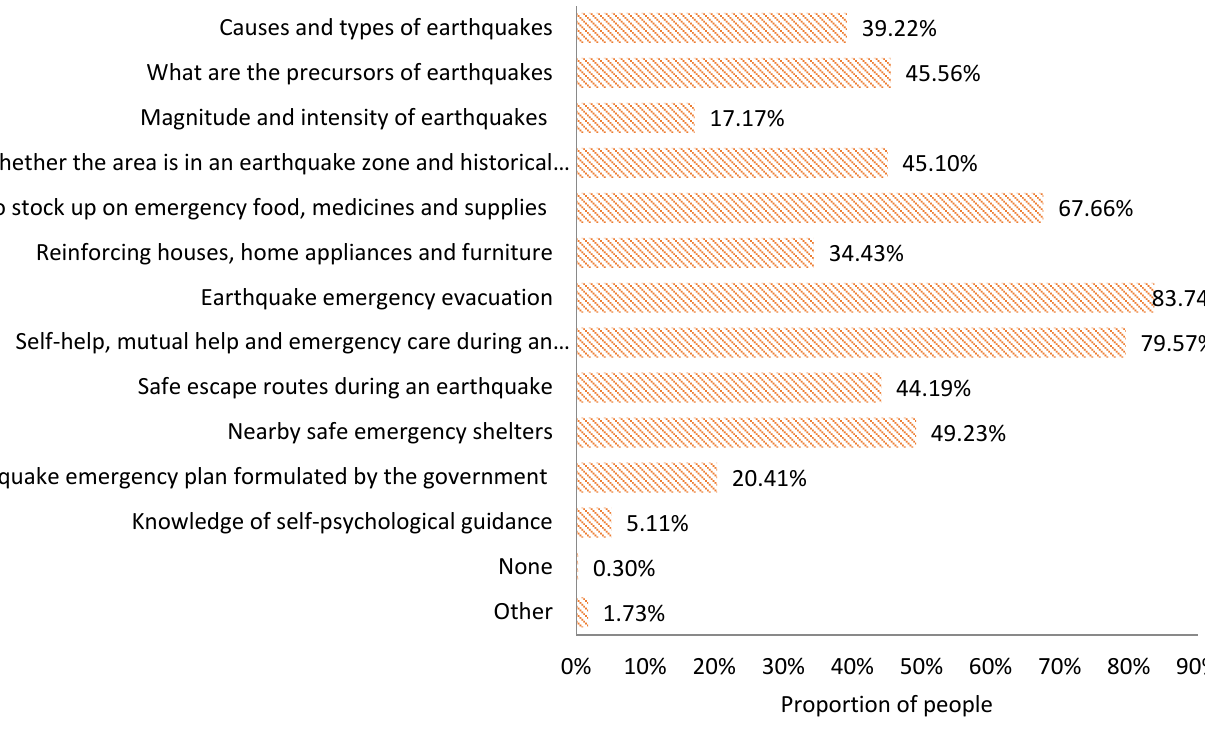
Figure 2. Information expected to be acquired by the public in the prodromal stage of an earthquake disaster.